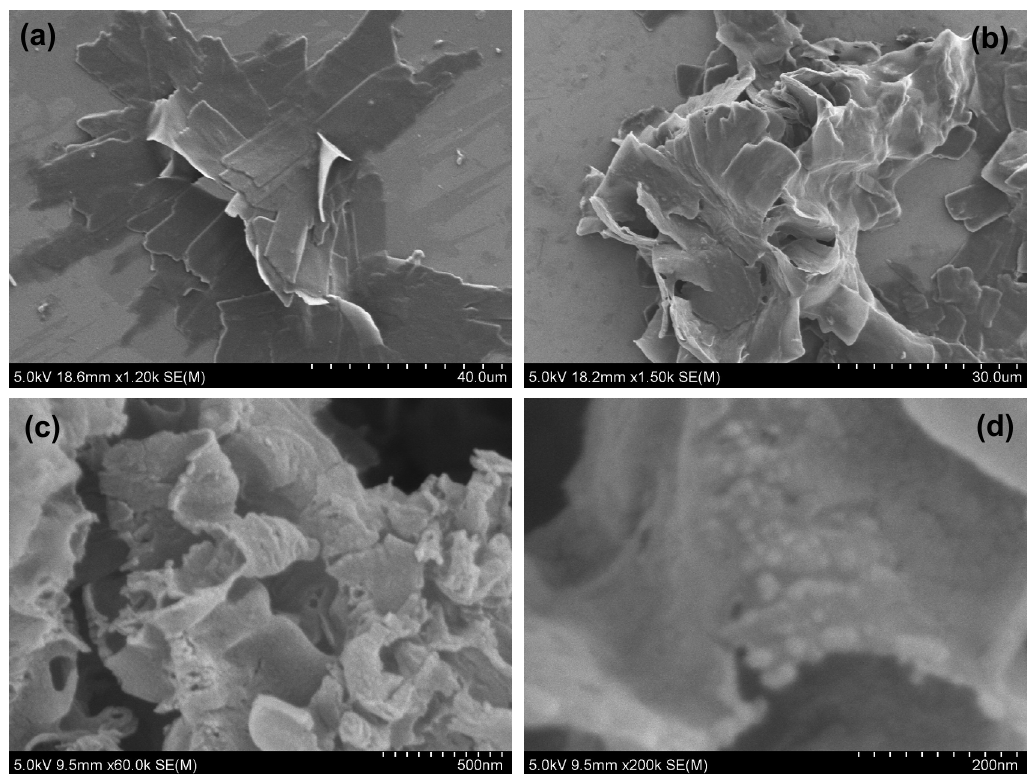
Figure 3. SEM micrographs of xanthan gum-cl-poly(acrylamide-co-alginic acid) hydrogel ( a – c ) before adsorption and ( d ) after adsorption .